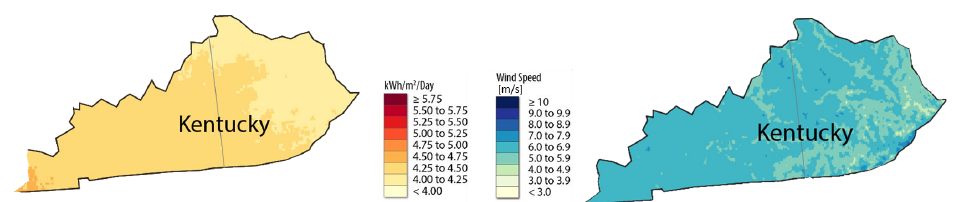
Figure 1. Maps of Kentucky annual average global horizontal irradiance and wind speed at 100 m hub height from NREL [8]. Kentucky experiences a mild climate with large seasonal variation, and is located at approximately 37.5° N by − 85.29°